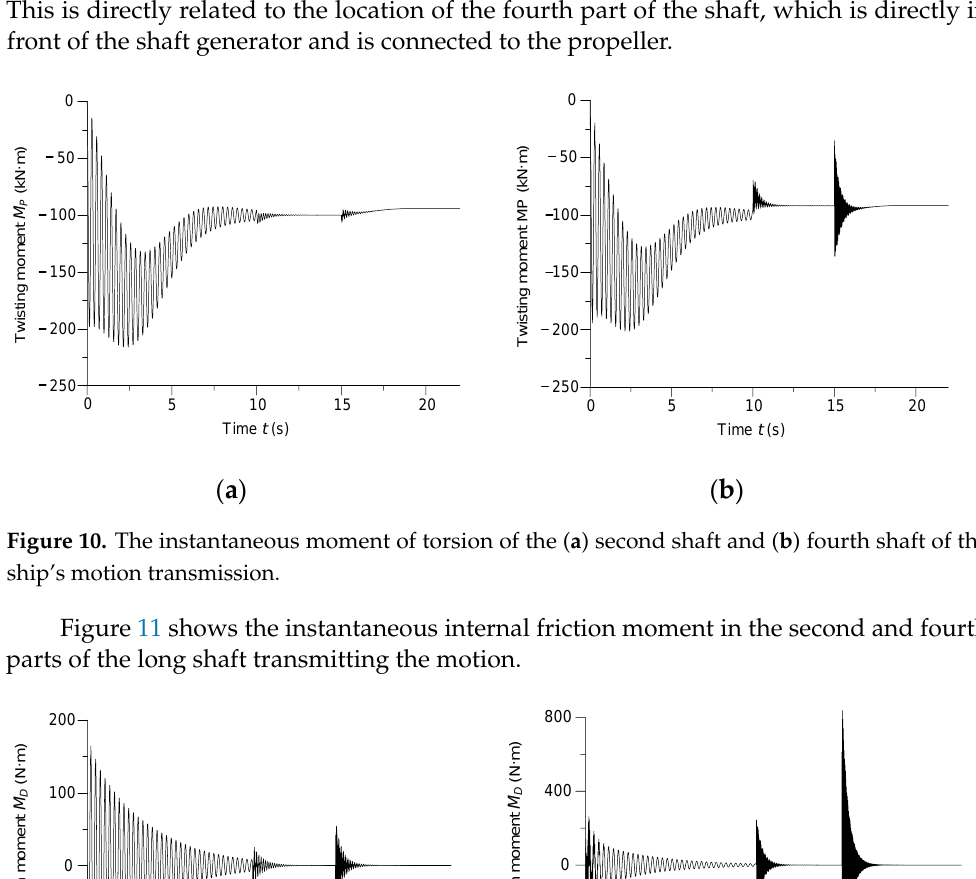
Figure 9. The instantaneous flux linkage for the excitation winding of the shaft generator. Figure 10 show the instantaneous moments of torsion in the centers of the second and fourth parts of the long drive shaft.